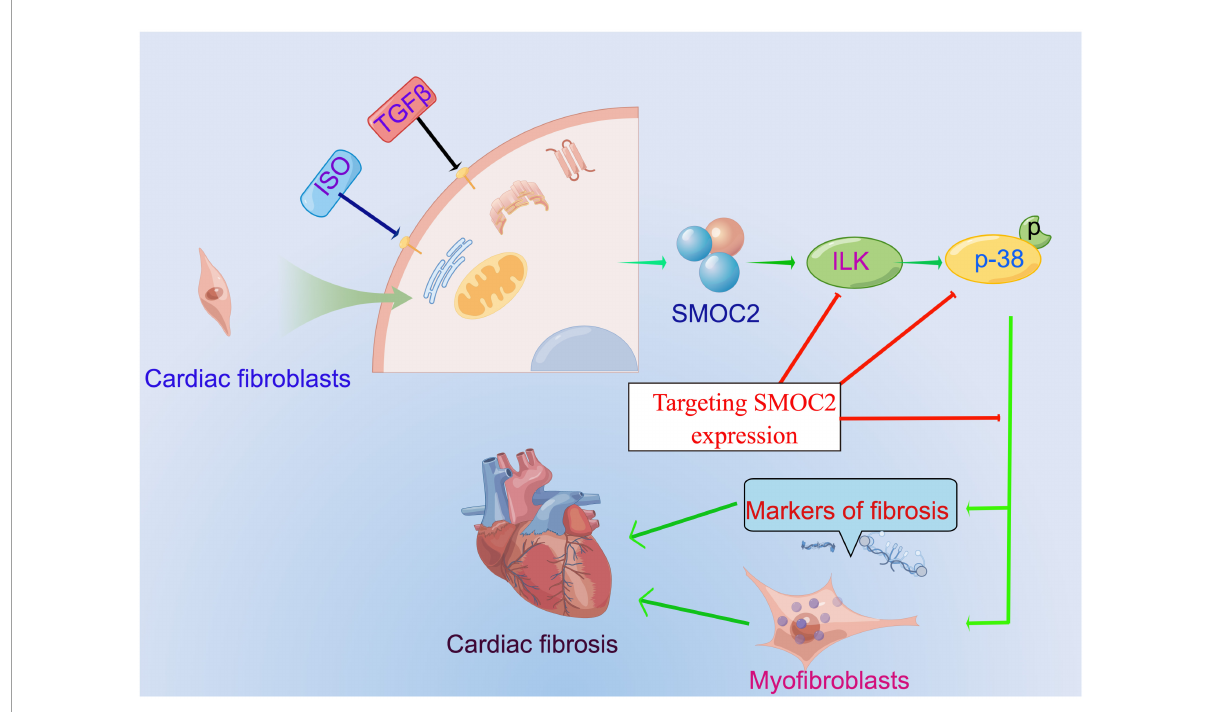
FIGURE8 The proposed working model of targeting SMOC2 expression on pathological cardiac